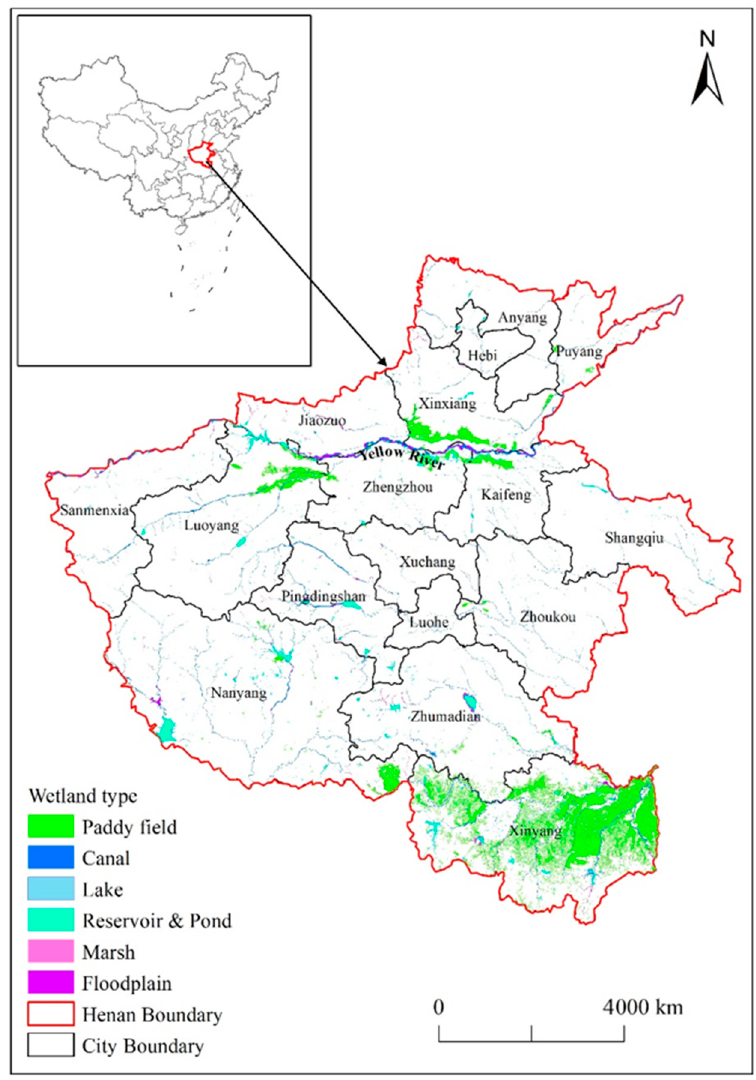
Figure 1. Wetlands spatial distribution in Henan Province of 2015. Table 2. The land use classification